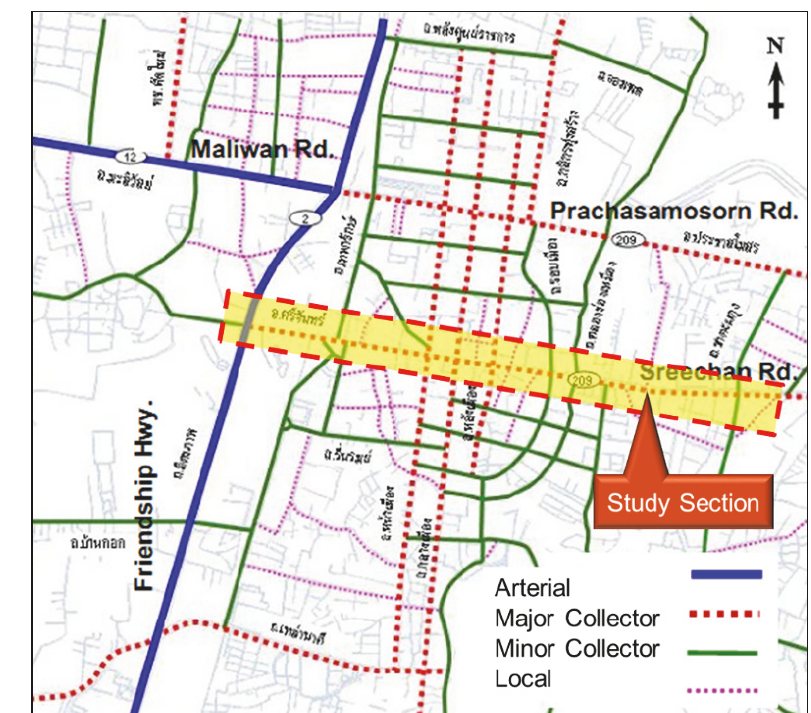
Figure 2: Sri Chan Rd. in Khon Kaen City road